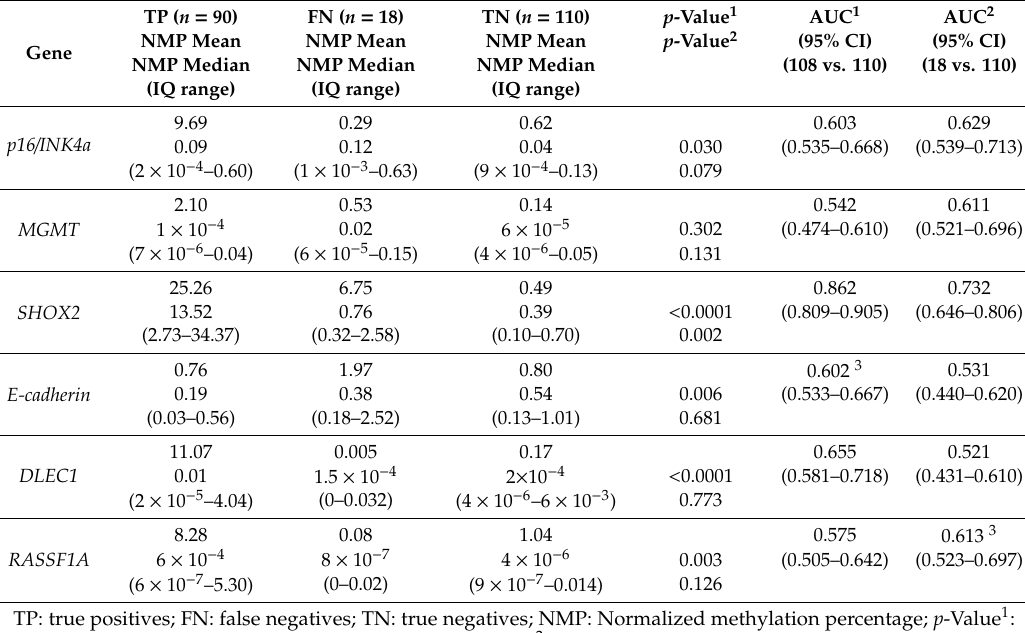
AUC 1 : area under the curve for the diagnosis of malignancy (TP and FN vs. TN); AUC 2 : under the curve for the diagnosis of malignancy (FN vs. TN). 3 : a lower result in the test (less methylation) implicates a more positive test.